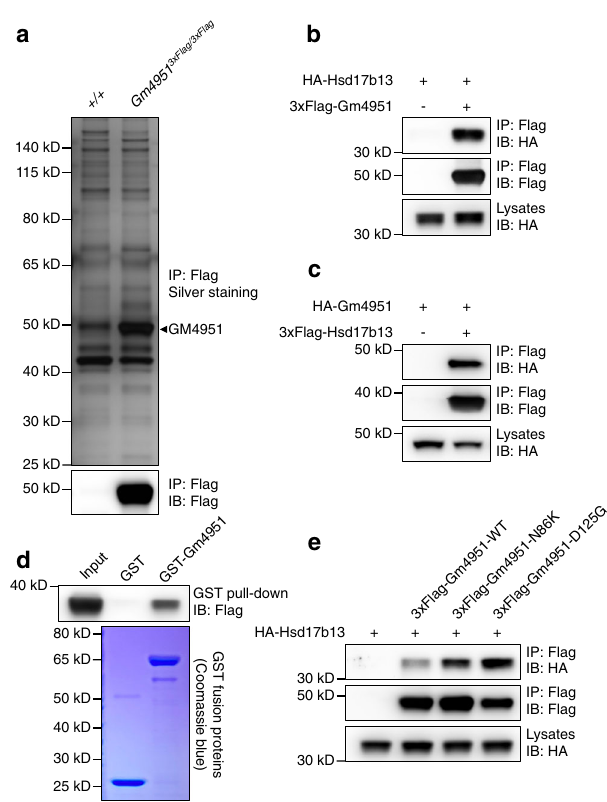
Fig. 6 GM4951 interacts with HSD17B13. a Silver staining (top) or immunoblot (bottom) of anti-Flag immunoprecipitates from + / + or Gm4951 3xFlag/3xFlag liver lysates. The same samples were analyzed by mass spectrometry to identify GM4951 interacting proteins. b Immunoblots of immunoprecipitates (top and middle) or lysates (bottom) of 293T cells expressing HA-tagged Hsd17b13 and 3xFlag-tagged Gm4951. c Immunoblots of immunoprecipitates (top and middle) or lysates (bottom) of 293T cells expressing HA-tagged Gm4951 and 3xFlag-tagged Hsd17b13. d Puri fi ed 3xFlag-tagged Hsd17b13 was incubated with GST or GST-tagged Gm4951. After GST pull-down, bound protein was analyzed by Flag immunoblot (top). The amounts of GST and GST-Gm4951 were visualized by Coomassie blue staining (bottom). e Immunoblots of immunoprecipitates (top and middle) or lysates (bottom) of 293T cells expressing HA-tagged Hsd17b13 and 3xFlag-tagged WT or mutant Gm4951. Data are representative of two independent experiments ( b – e ) or from one experiment ( a